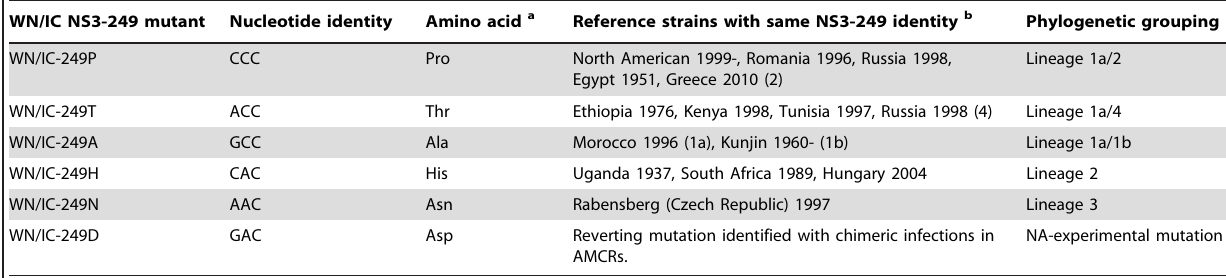
WN/IC NS3-249 mutant Nucleotide identity Amino acid a Reference strains with same NS3-249 identity b